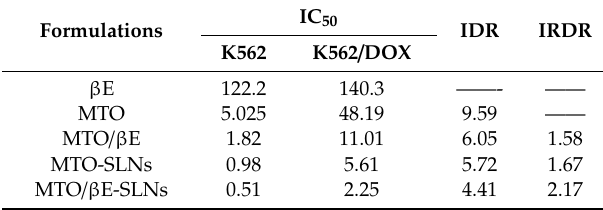
Table 3. The IC 50 , index of drug resistance (IDR), and index of reversal of drug resistance (IRDR) of MTO in K562 cells and K562/DOX cells treated with different formulations ( n = 3).